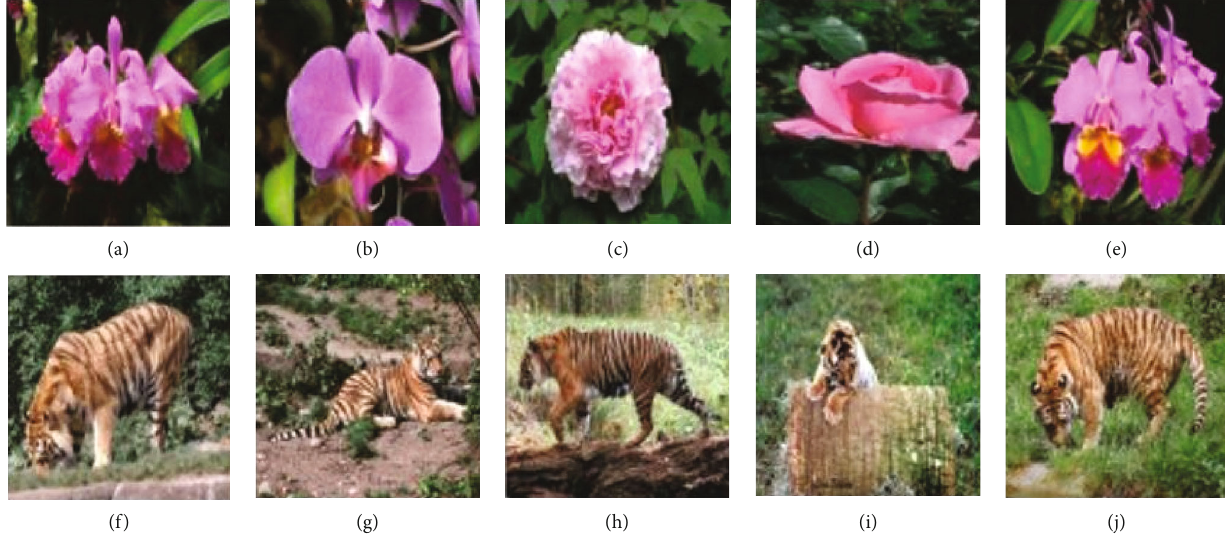
Figure 10: Generated results through proposed approach. (a) Original image, (b – e) retrieved mages when (a) is given as criterion image, (f) original image, and (g – j) retrieved images where (f) is used as